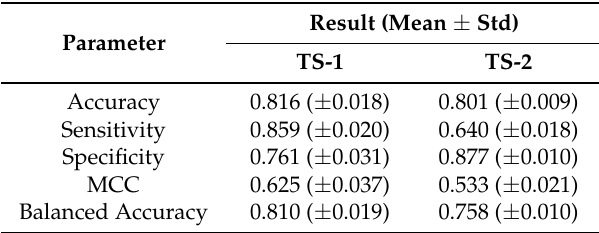
Table 3. Cross validation